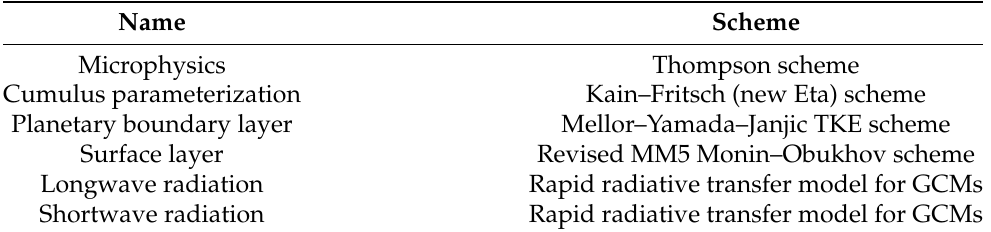
Table 2. Physical parameterization